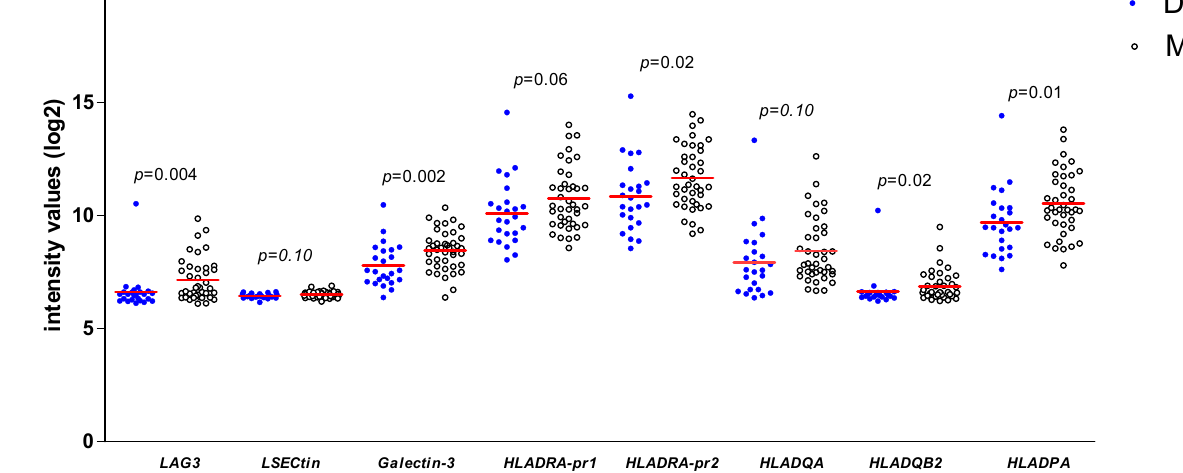
Figure 3. Comparison of gene expression of LAG3 , LSECtin , Galectin-3 , and several HLA class II molecules in 64 UM from Leiden between D3 ( n = 24) and M3 ( n = 40) UM; a Mann–Whitney U test was applied. Horizontal bars indicate mean gene expression. p ≤ 0.05 is considered significant.